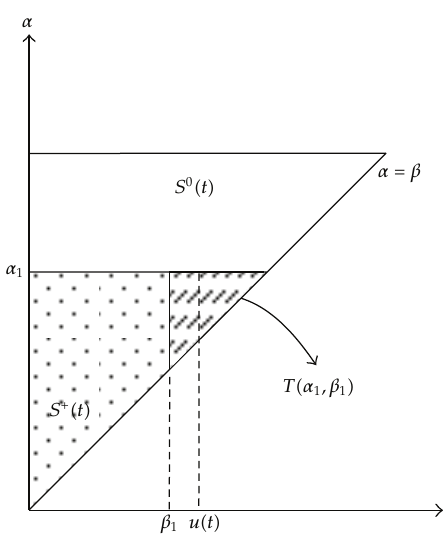
Figure 6: α - β plane due to input decreasing to β 1 from α 1